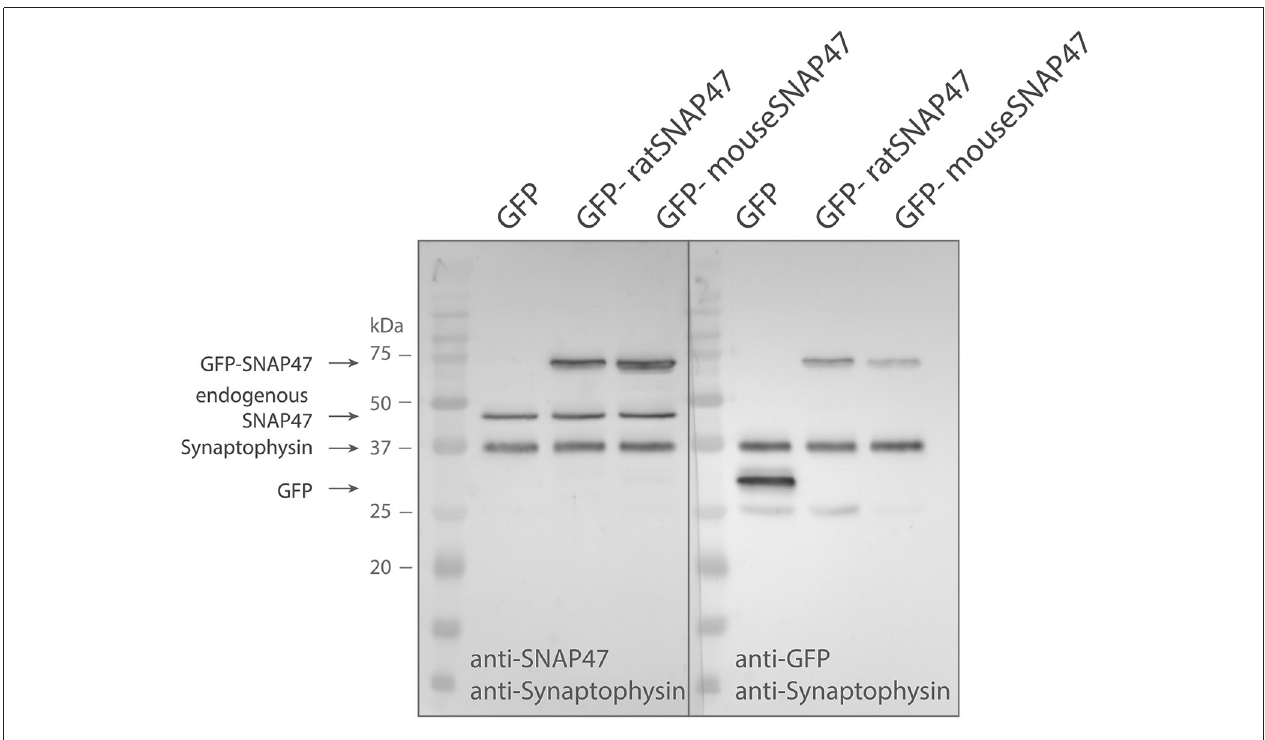
FIGURE 1 | Specificity of the SNAP47 antibody confirmed by the western blot of cultured WT hippocampal neurons infected with lentivirus expressing GFP-tagged mouse or rat SNAP47. Cultured WT hippocampal neurons were infected with either GFP (left lanes), GFP-mouse-SNAP47 (middle) or GFP-rat-SNAP47 (right) expressing lentiviral particles. From these cultures, 30 µ g of protein lysates were loaded per lane and subjected to western blotting. The blot on the left was incubated with the rabbit polyclonal anti-SNAP47 antibody, the blot on the right was incubated with an anti-GFP antibody. Synaptophysin ( ∼ 37 kDa) expression served as internal loading control detected by an anti-synaptophysin antibody. Note that the anti-SNAP47 antibody specifically recognizes the mouse or rat GFP tagged SNAP47 ( ∼ 74 kDa) as well as the endogenously expressed SNAP47 protein (47 kDa). The anti-GFP antibody in the western blot on the right detects the expression of GFP ( ∼ 27 kDa) and the GFP-tagged SNAP47 but not the endogenous